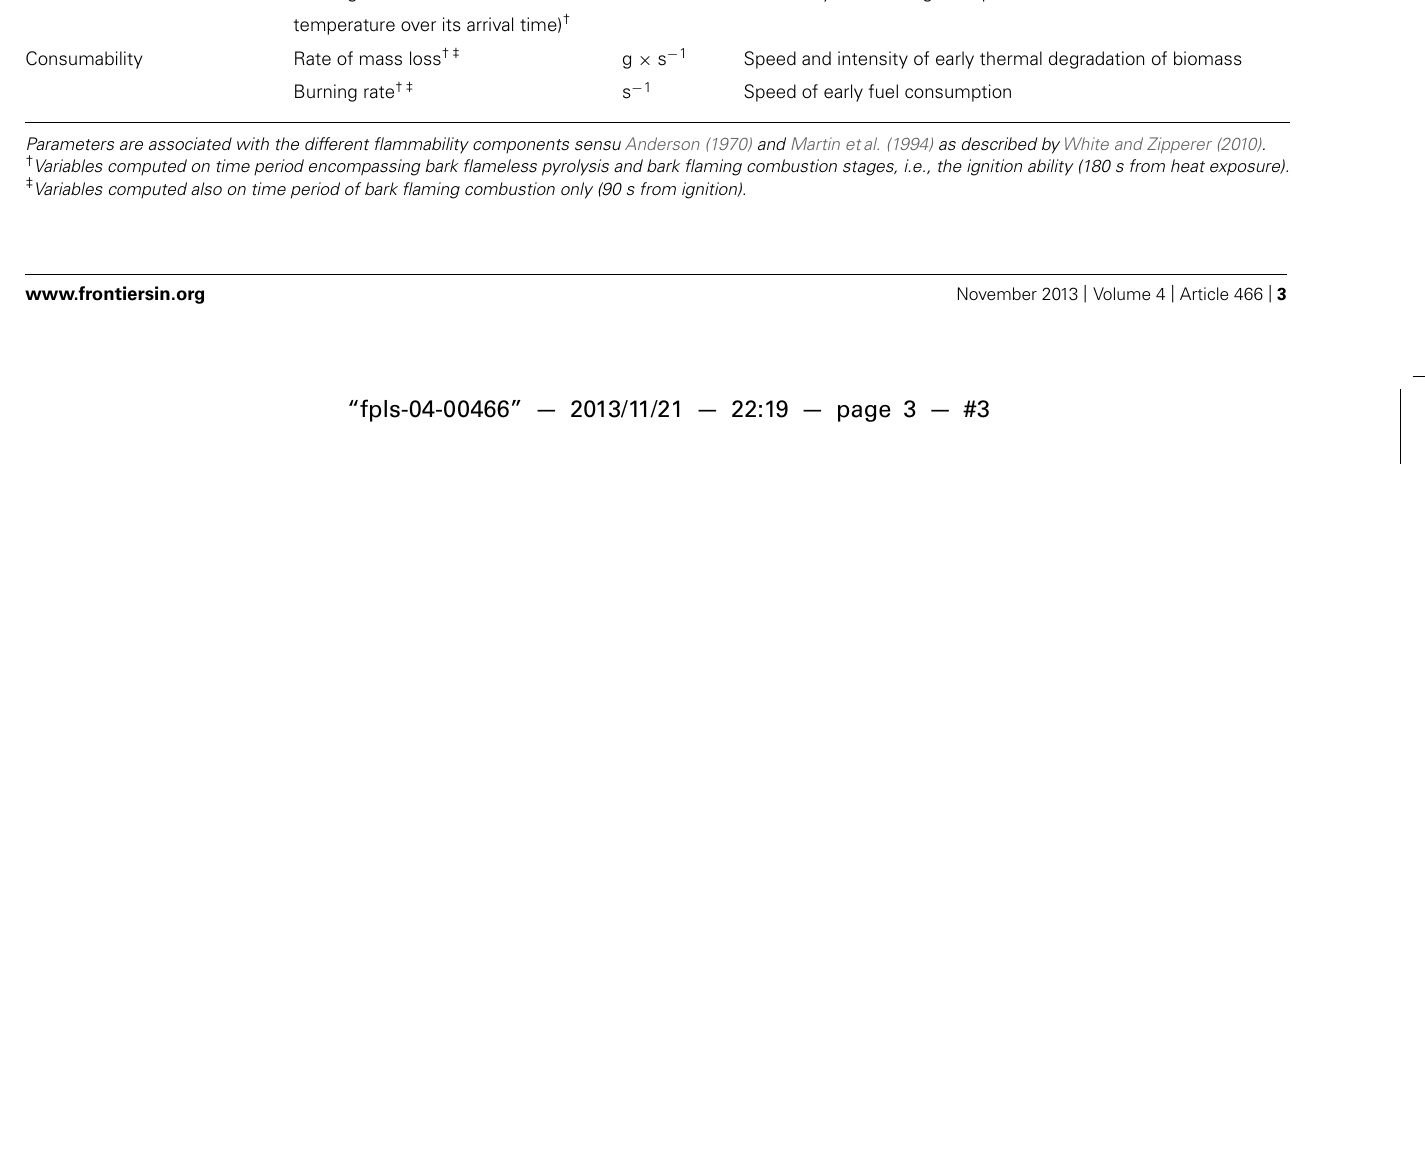
Table 1 | Flammability parameters, components, definitions and the processes they describe Flammability component